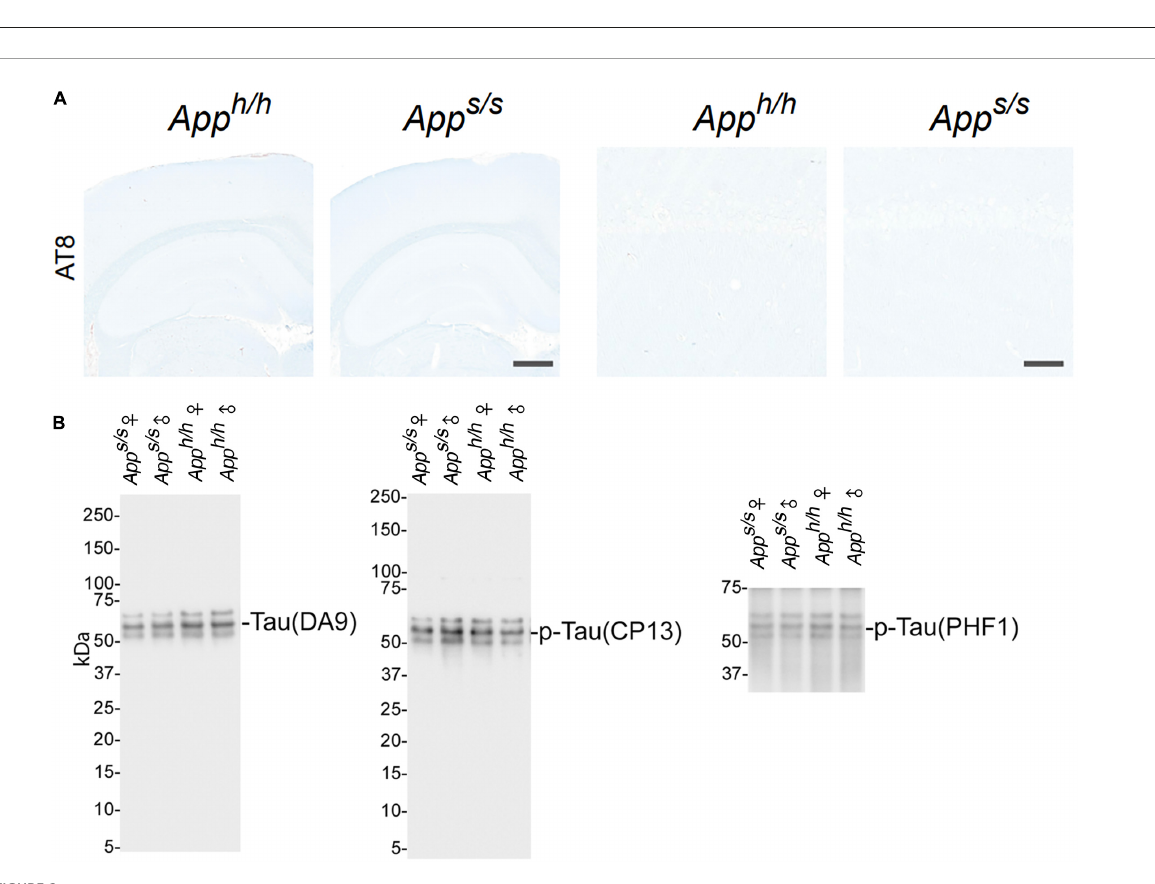
FIGURE6 Analysis of tau pathology and phosphorylation in App h / h and App s / s rats brains. (A) Histopathological analysis, using the anti-phospho-Tau antibody AT8 staining, of 14-month-old App h / h and App s / s rats ( App h / h , 5 male and 4 female rats, and App s / s , 5 male and 5 female). The left panels show representative images of the anterior hippocampus and overlaying somatosensory cortex of App h / h and App s / s rat brains. The scale bar is equivalent to 500 microns. The right panels show high-magnification picture of the hippocampal CA1 subregion for the staining depicted in the left panels. The scale bar is equivalent to 50 microns. (B) WB of brain lysates from App s / s and App h / h rats with DA9, CP13 and PHF1, which recognize: total Tau, tau phosphorylated on S 202 , and tau phosphorylated on S 396 − 404 , respectively. The samples analyze are the same used in Figure 4A